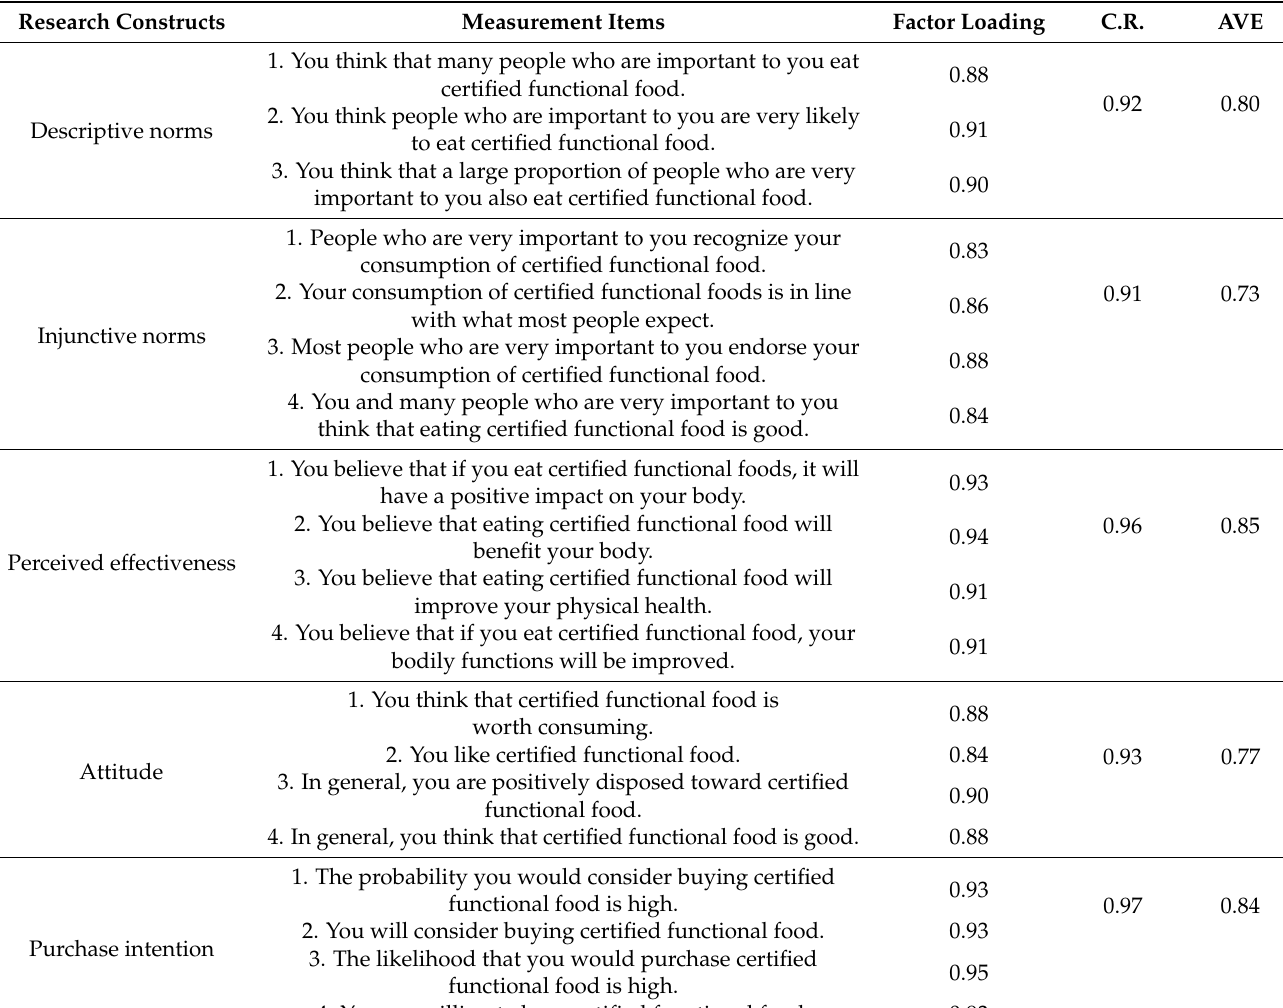
Table 1. Accuracy analysis